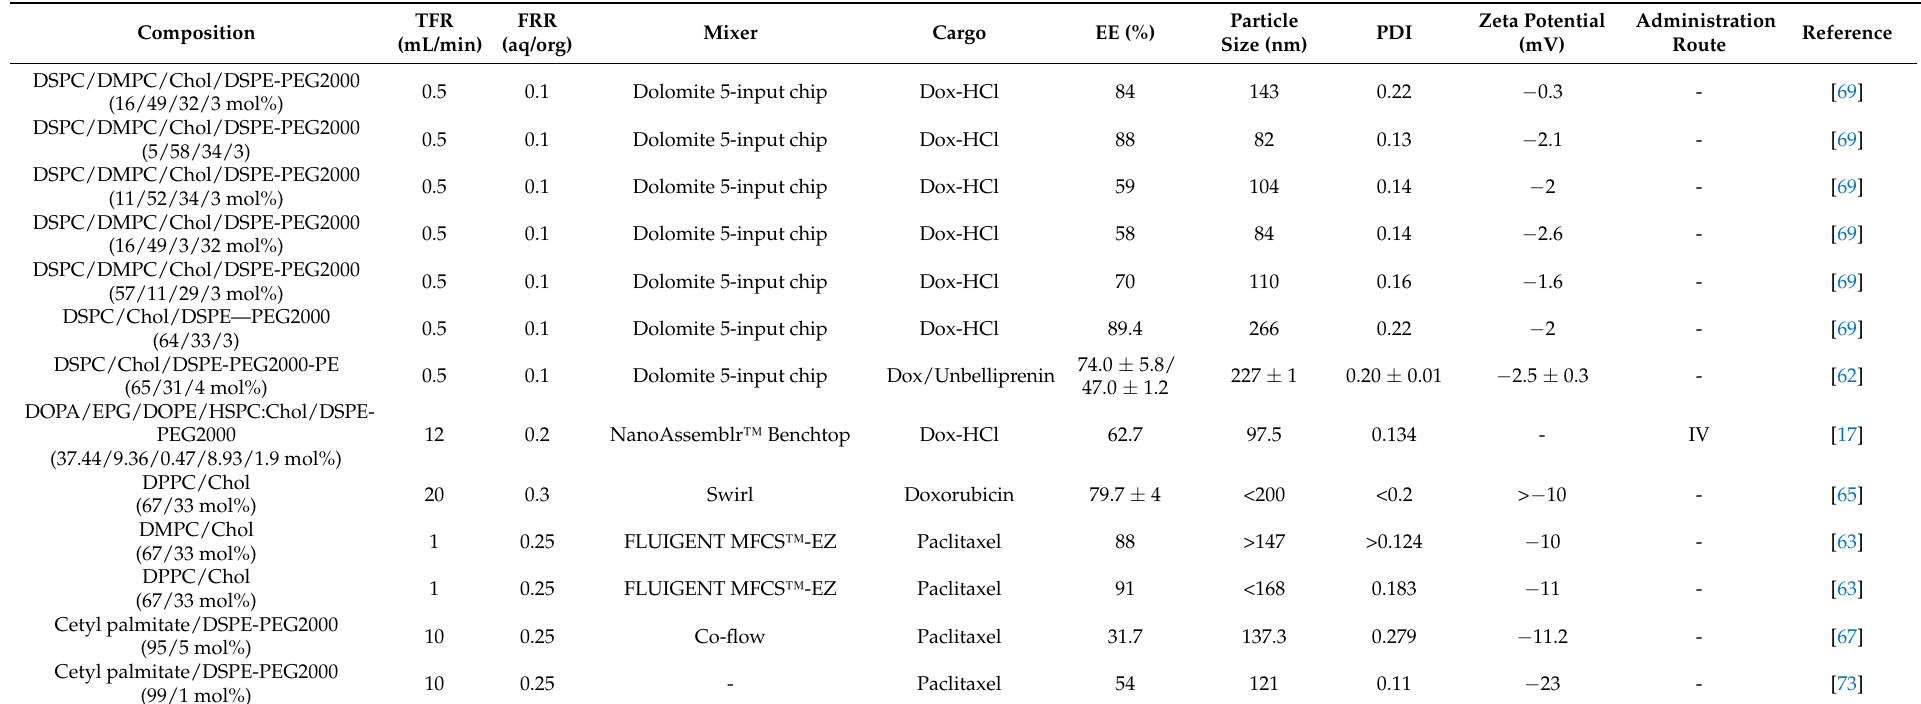
Table 5. Small-molecule LBNPs for drug delivery and their physicochemical